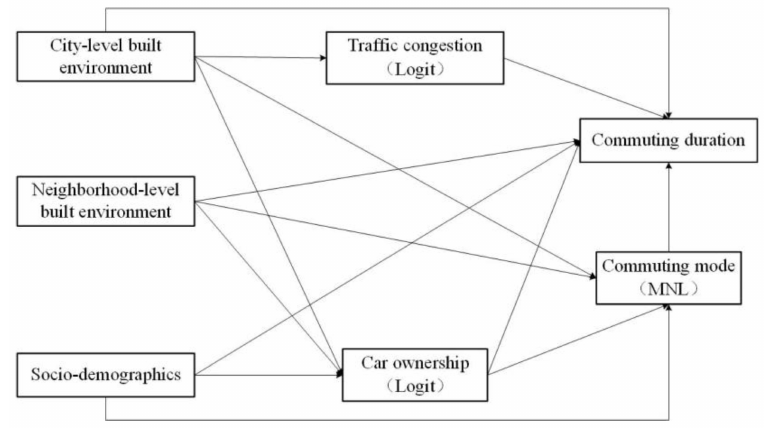
Figure 1. Conceptual framework.